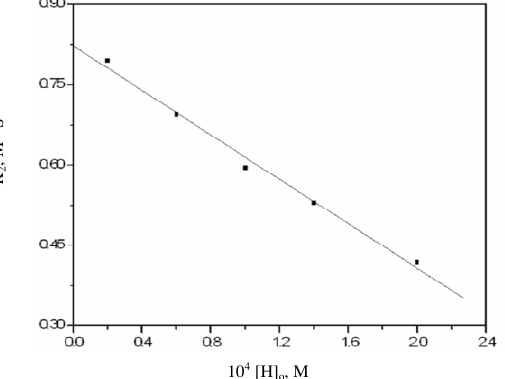
Figure 2. Effect of [H + ] in the oxidation of PTAA with NCSA.